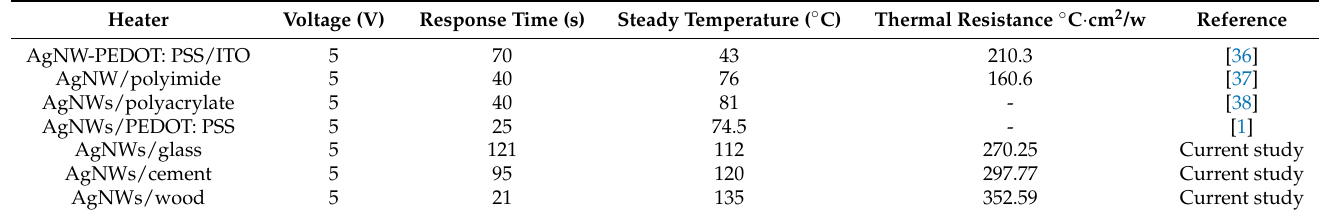
Table 1. Comparison between the current study and the literature for the important parameters of heaters based on AgNWs.